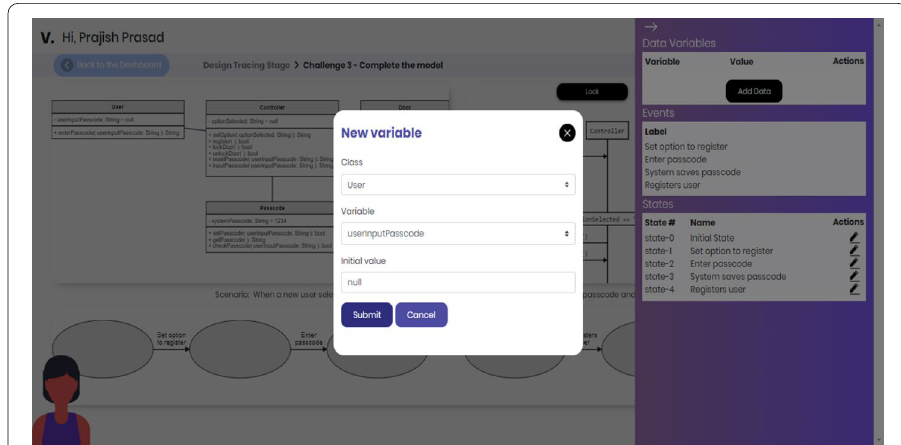
Fig. 7 In Challenge 3, learners add relevant data variables to the state diagram